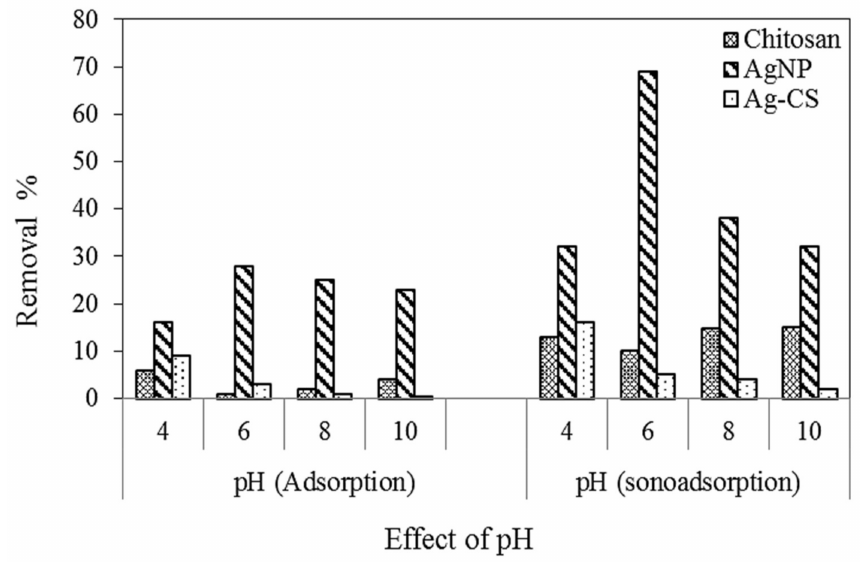
Figure 7. Effect of pH on adsorption and sono-adsorption of MB using chitosan, AgNPs, and AgCS (MB concentration = 5 mg L − 1 , chitosan concentration = 0.005 g, AgNPs dosage = 0.005 g, AgCS = 0.005 g, time = 120 min, US power 80